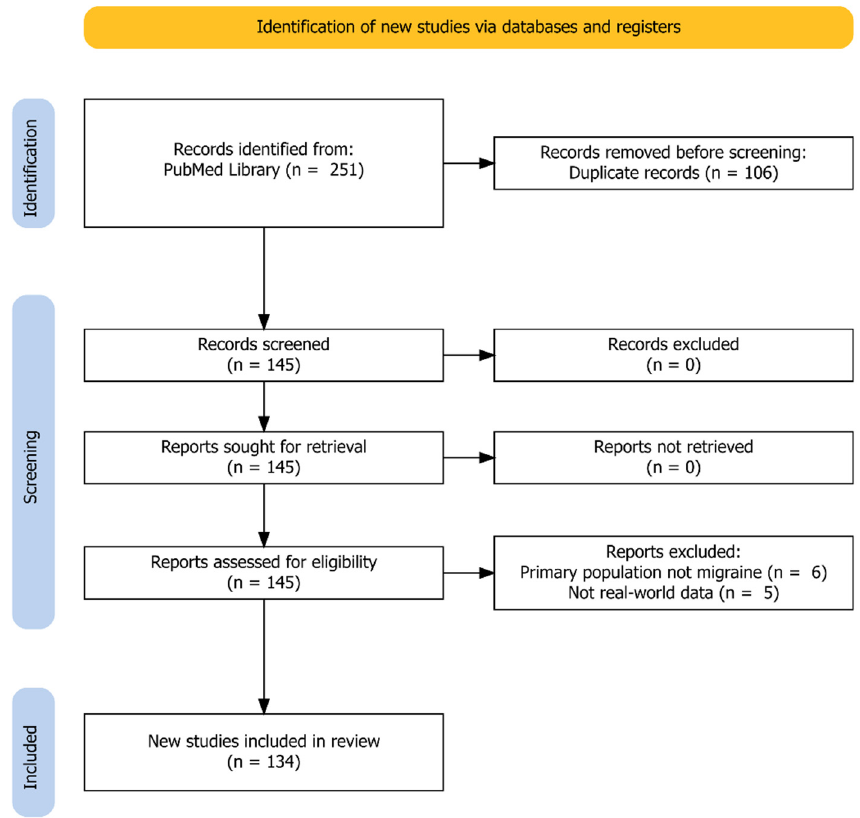
Figure 1. Identification of studies according to the PRISMA Guidelines (Preferred Reporting Items for Systematic Reviews and Meta-Analyses).